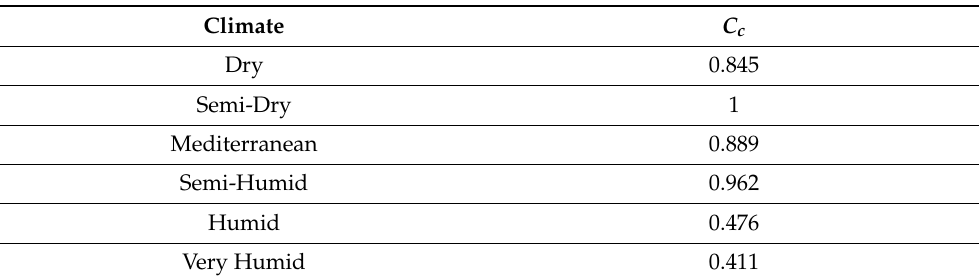
Table 3. Climatic correction coefficient ( C c ) values obtained with the two-parameter input combina- tion for different climate